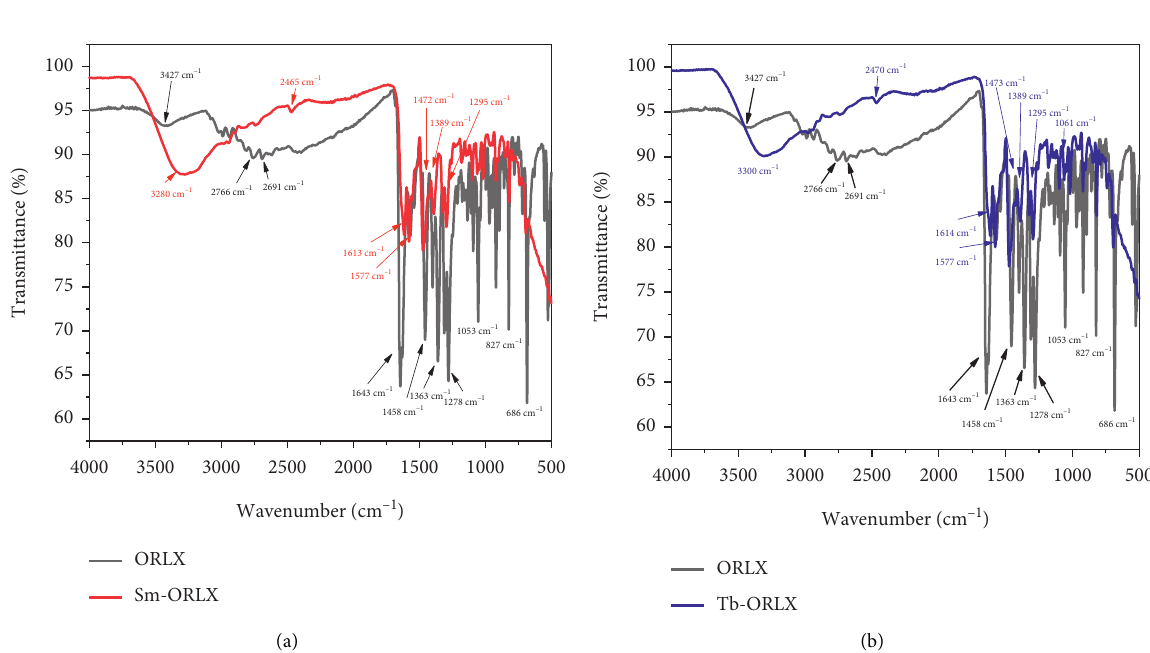
Figure 5: FT-IR spectrum of ORLX and ORLX-Sm(III) complex (a) and ORLX and ORLX-Tb(III) complex